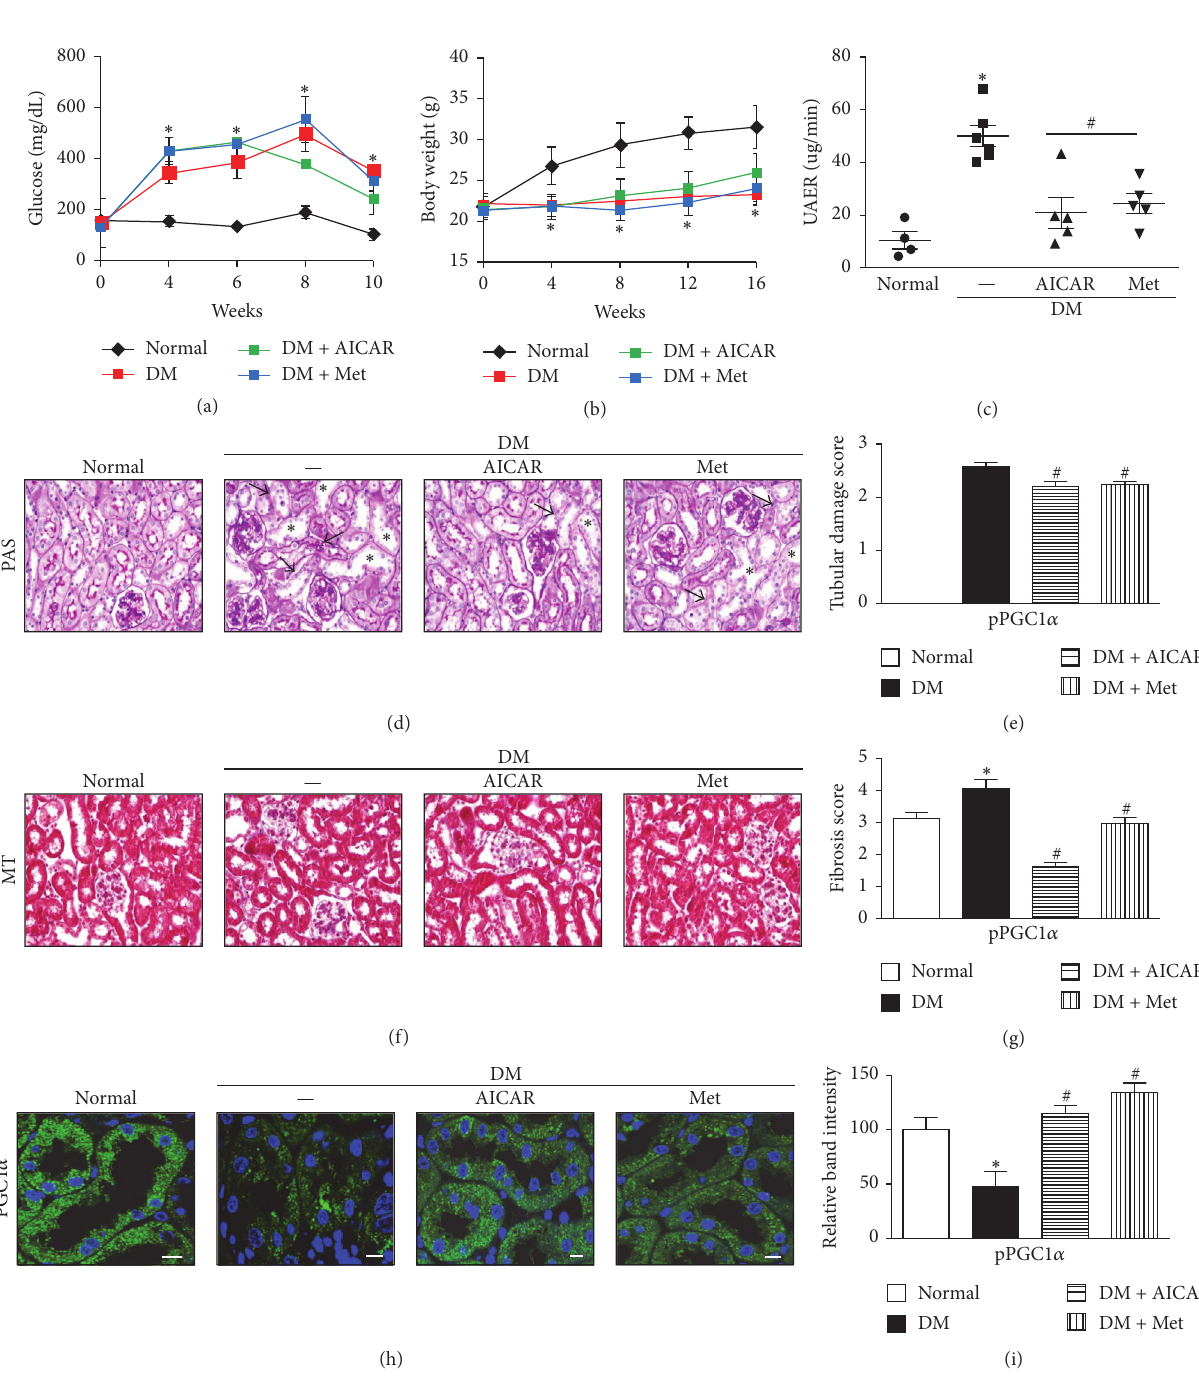
Figure 6: AICAR and metformin increase PGC1 𝛼 expression and ameliorate albuminuria and renal morphologic characteristics in kidneys of streptozotocin- (STZ-) induced diabetic mice. (a and b) The STZ-induced diabetes group had higher blood glucose levels and reduced body weights compared with the normal control group. (c) The STZ-induced diabetic mice treated with AICAR or metformin exhibited a significant reduction in urine albumin excretion rate (UAER). (d and e) Tubular dilatation (asterisk) and tubular epithelial disruption (arrow) were observed in the diabetic control group. Treatment of STZ-induced diabetic mice with AICAR or metformin resulted in less cellular disruption. (f and g) Representative photographs of Masson’s trichrome-stained kidneys showed decreased renal fibrotic lesions in both AICAR and metformin-treated groups compared with the diabetic control group. (h and i) Restored PGC1 𝛼 activity was confirmed by immunofluorescence and immunoblot analysis in diabetic kidneys treated with AICAR or metformin ( ∗ 𝑝 < 0.05 versus normal; # 𝑝 < 0.05 versus diabetic control; scale bar 10 𝜇